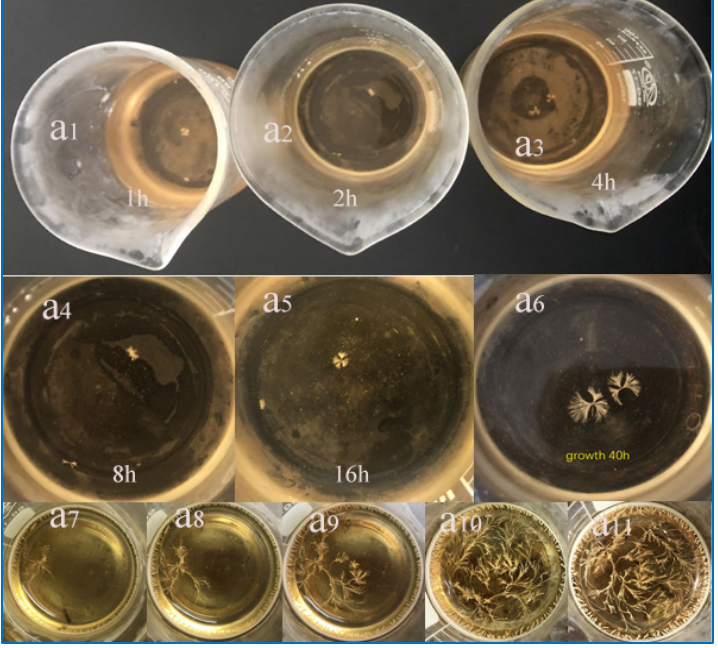
Figure 3. EVA crystal growth in CMCS/EVA co-mixture gels with appearances from leaves ( a1–a6 ) to trees ramification ( a7–a11 ).